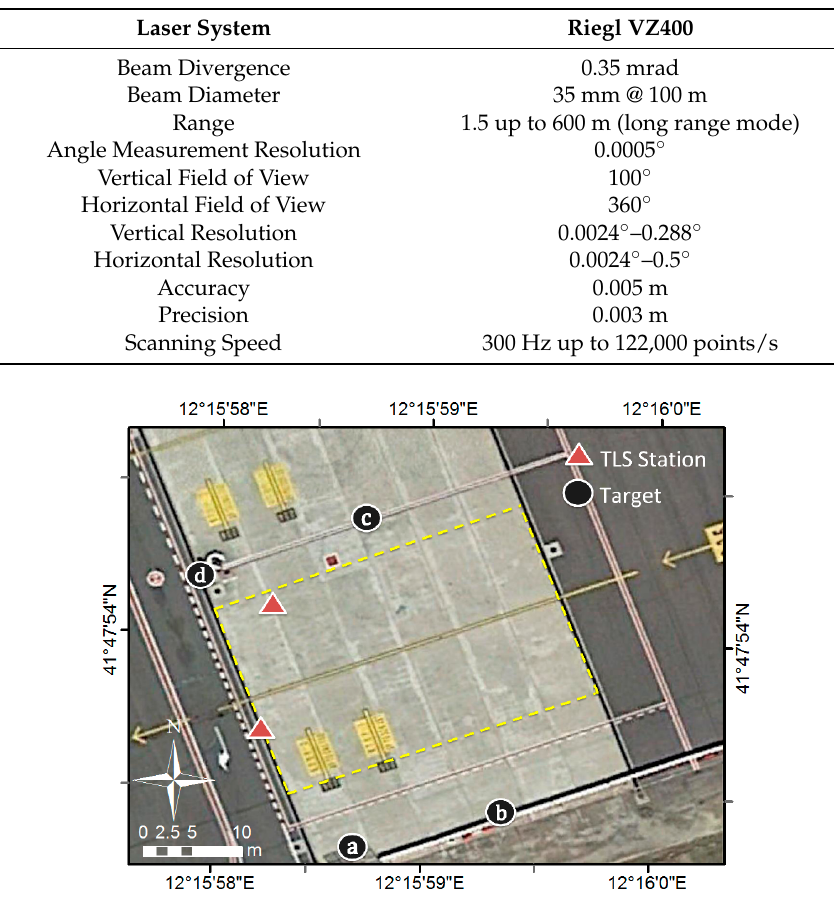
Table 2. Summary statistics of the georeferencing residuals.